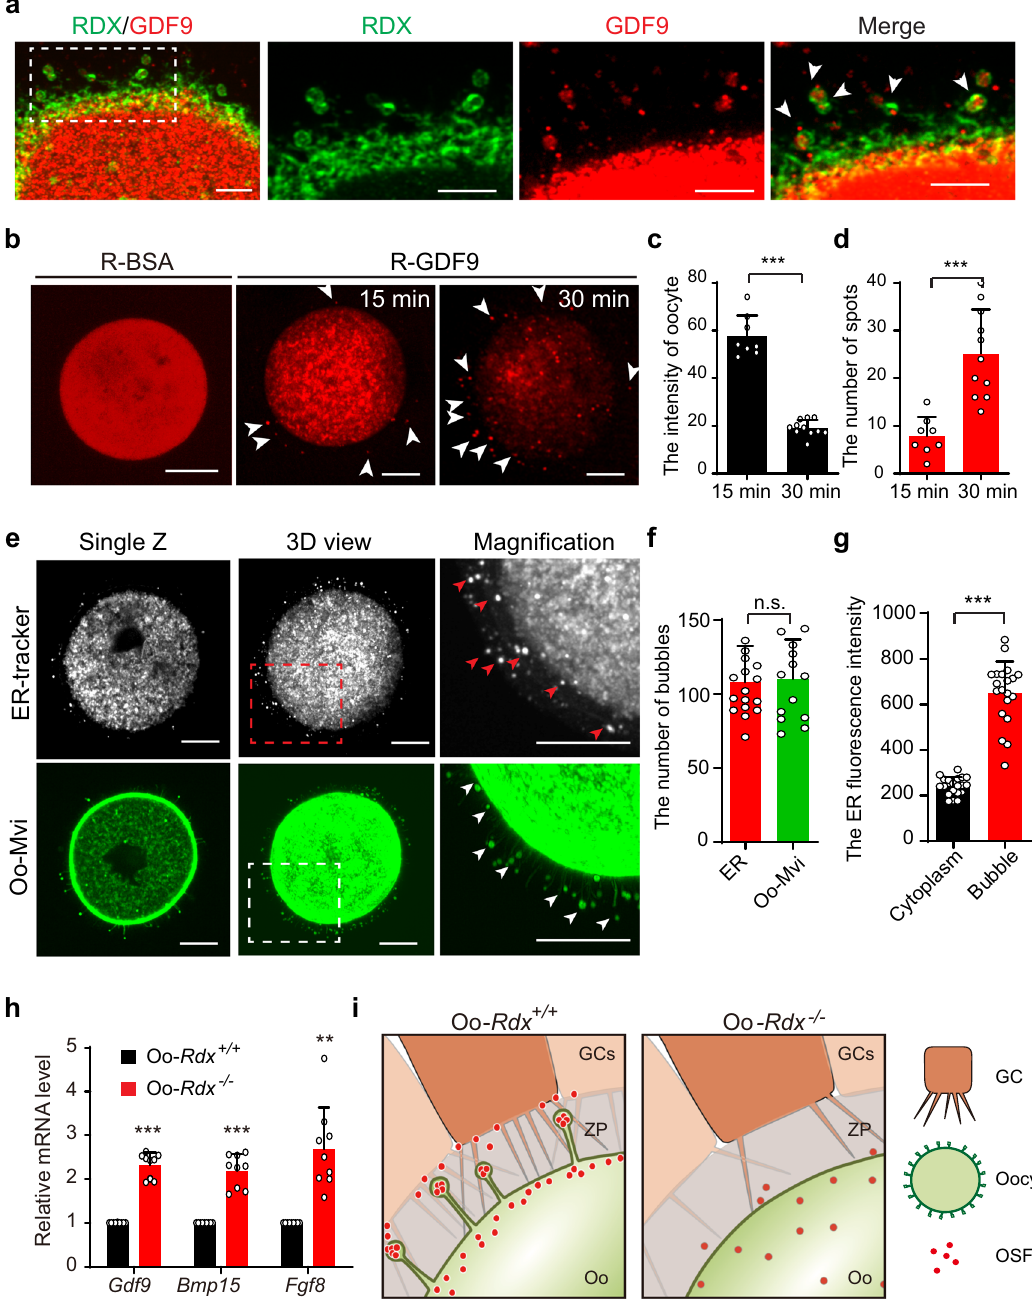
Fig. 6 OSFs were enriched in Oo-Mvi to manipulate the development of follicles. a GDF9 was localized in the vesicles of Oo-Mvi. Immunostaining showing GDF9 protein (Red, arrowheads) localized in the oocytes and the vesicles of Oo-Mvi (Green, RDX). n = 29 ovarian follicles. b Rhodamine-labeled GDF9 (R-GDF9) or BSA (R-BSA) was microinjected into living oocytes at GV stage ( n = 15 per group), and the R-GDF9 intensity and distribution were detected at 15 or 30 min after injections (Supplementary Movies 4 and 5). The R-GDF9 spots surrounding the oocytes were pointed by arrowheads. c , d A time-dependent decrease of R-GDF9 intensity in oocytes ( c ) and increase of the number of R-GDF9 spots ( d ) were observed after injections. P -value: 0.0000014 ( c ), 0.00064 ( d ). e ER-tracker staining showed a cloudy ER distribution (top) in the oocyte cytoplasm, and the many ER bubbles (top, arrowheads) surrounding oocytes (Supplementary Movie 6), which were similar to the R-GDF9 distribution ( b , arrowheads) and Oo-Mvi vesicles (bottom, arrowheads). f Quanti fi cation of the number of ER bubbles ( n = 17) and Oo-Mvi vesicles ( n = 14). P -value = 0.81. g Quanti fi cation of the fl uorescence intensity of ER in oocyte cytoplasm and bubbles ( n = 20). P -value = 0.00000009. h Relative mRNA levels of Gdf9 , Bmp15, and Fgf8 in Oo- R dx + / + and Oo- Rdx − / − oocytes showing a decreased consumption of OSFs in the oocytes of Oo- Rdx − / − females. P -value: 0.000006 ( Gdf9 ), 0.0001 ( Bmp15 ), 0.0019 ( Fgf8 ). i The proposed model of the function of Oo-Mvi in follicle development and female reproduction, showing that Oo-Mvi in the ZP determine the fate of individual follicles by regulating oocyte-GC communication. Data are presented as the mean ± SD with experiments performed in triplicate, and representative images are shown. Data were analyzed by two-tailed unpaired Student ’ s t -test and *** P < 0.001, ** P < 0.01, and n.s. P ≥ 0.05. Scale bars: 5 μ m ( a ); 20 μ m ( b , e